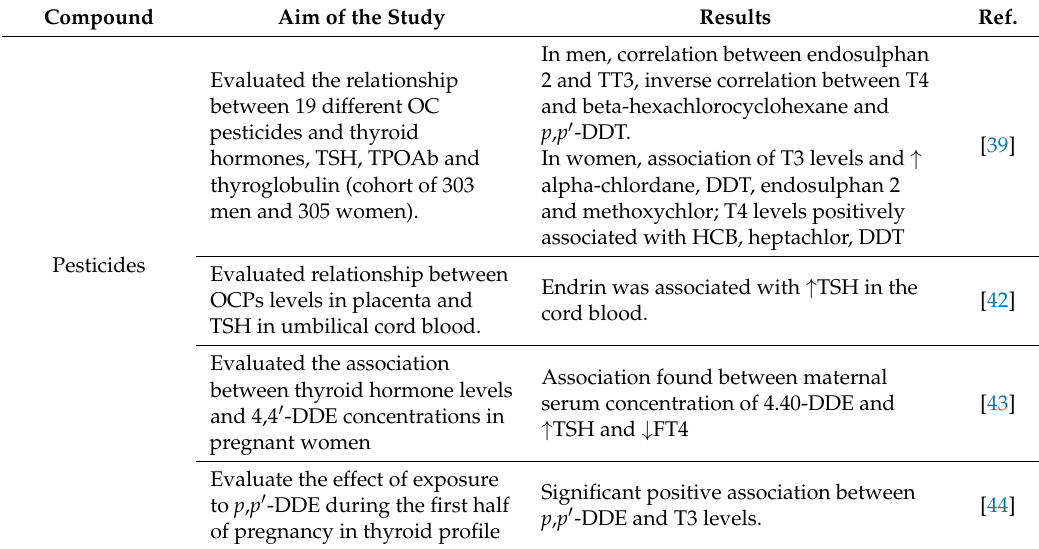
Table 2. Major studies on pesticides and main results